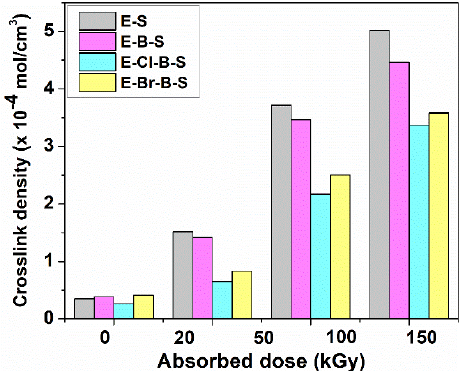
Figure 5. Variation in gel content for EPDM composites with irradiation dose.